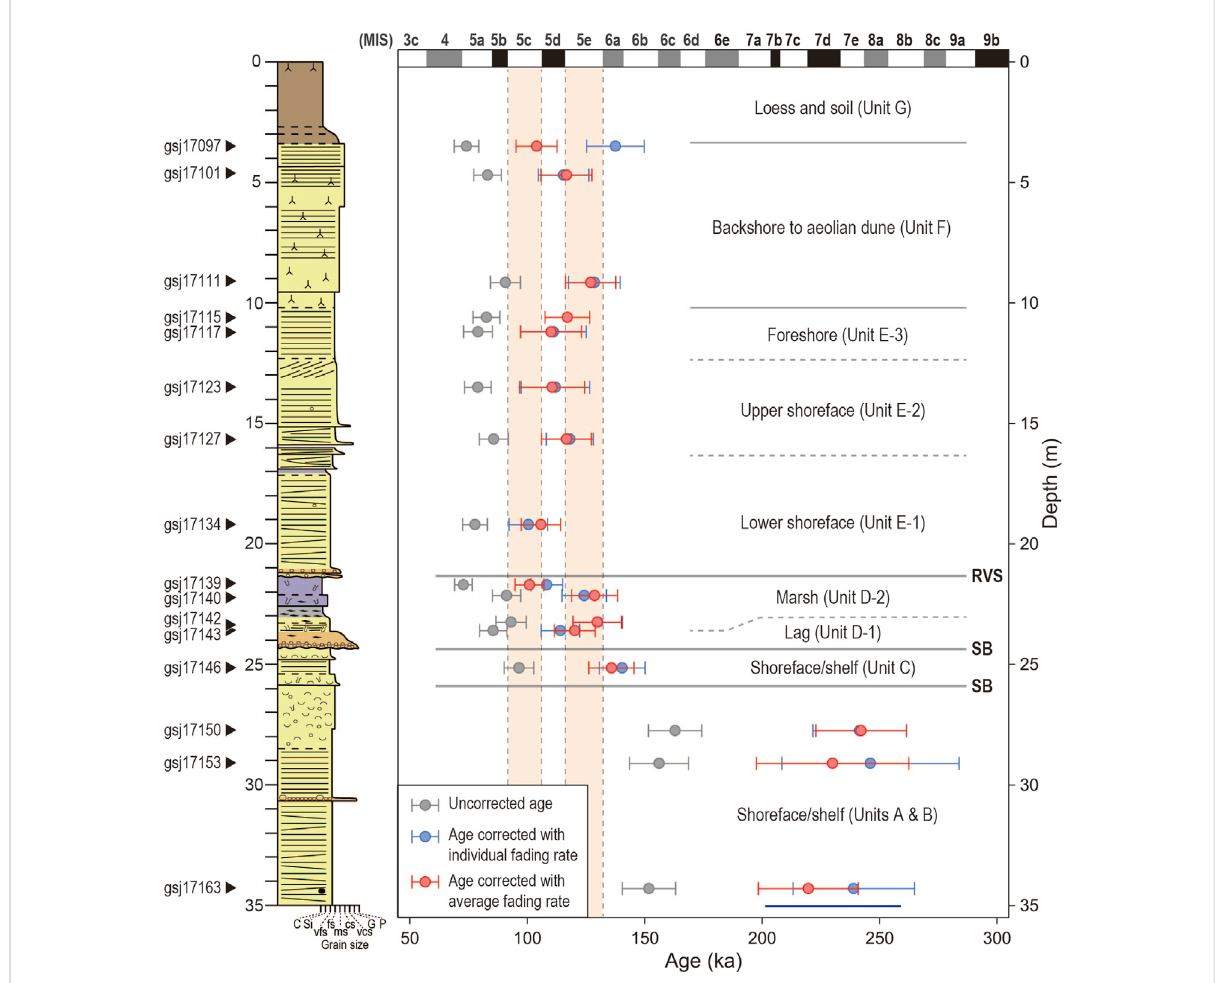
FIGURE 7 PlotsofuncorrectedandcorrectedpIRIR 225 agesof16samplesincoreGS-HKT-1againstcoredepth.TheinvervalsofMIS5cand5eareshaded. The color legend of the core is shown in Figure